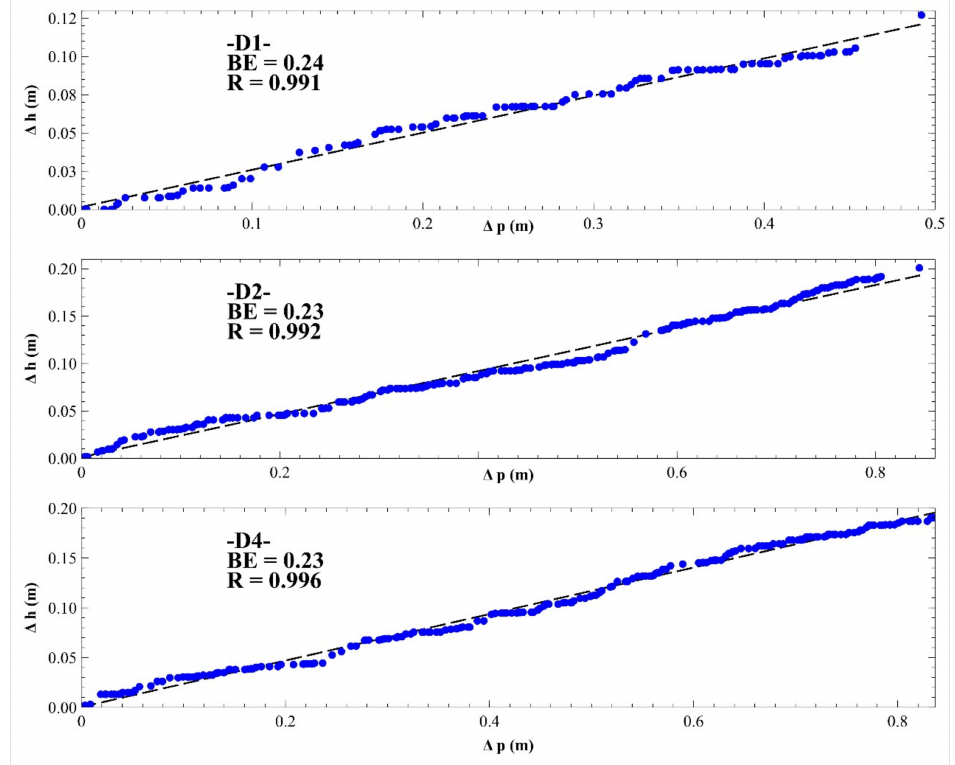
Figure 7. Determination of barometric e ffi ciency, BE , for piezometric head series from D1, D2, and D4 for the period 1 August to 31 August